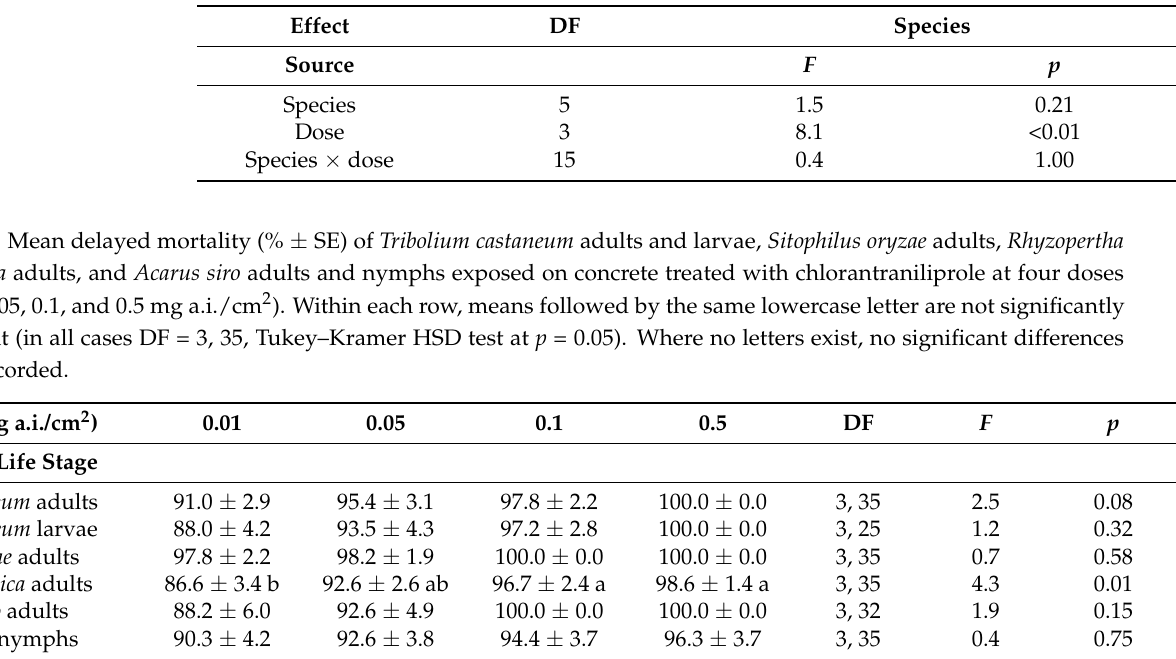
Table 8. ANOVA parameters for main effects and the associated interaction for delayed mortality of Tribolium castaneum adults and larvae, Sitophilus oryzae adults, Rhyzopertha dominica adults, and Acarus siro adults and nymphs (total DF = 202).